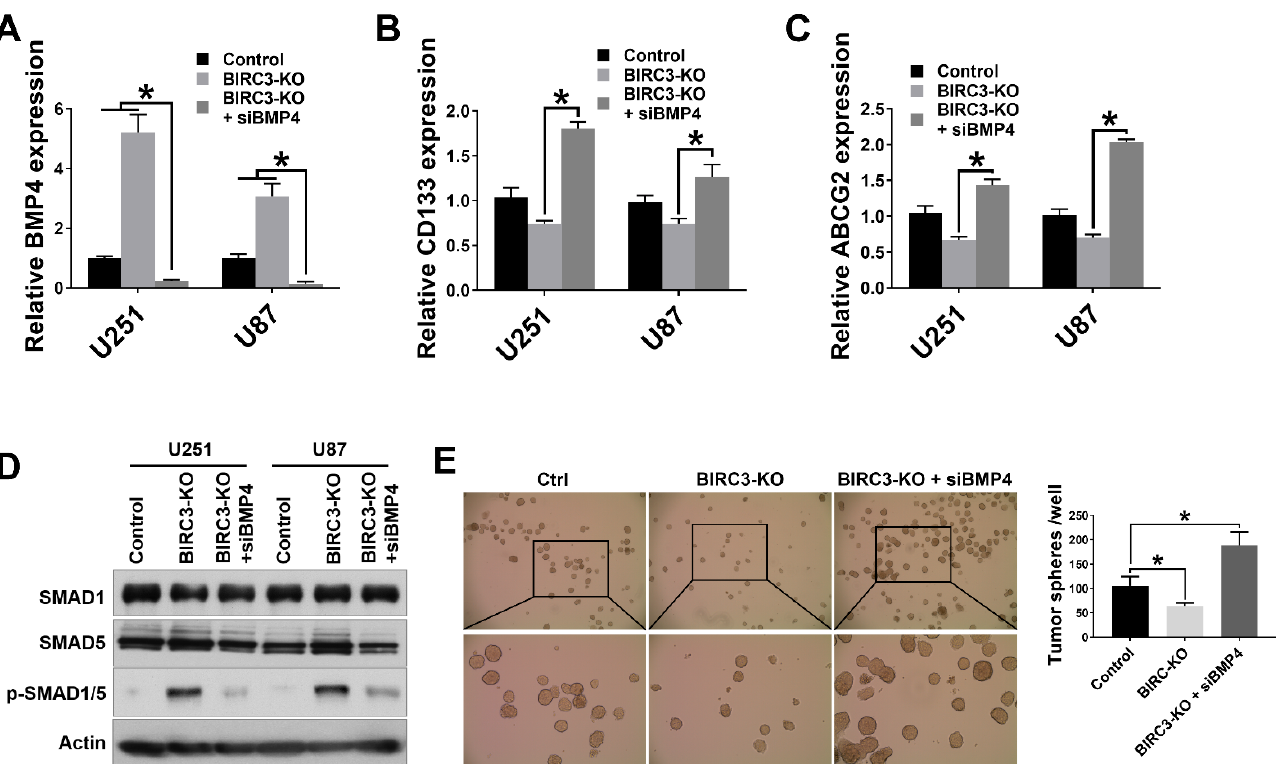
Figure 4. BIRC3 impacts GBM cell self-renewal and is dependent on BMP4 suppression. ( A ). Human BMP4 mRNA expression analyzed by real time PCR in control, BIRC3-KO, and BMP4-siRNA silenced BIRC3-KO U251/U87 GBM cell lines. n = 3, * p < 0.05. ( B ). Human CD133 mRNA expression analyzed by real time PCR in control, BIRC3-KO, and BMP4-siRNA silenced BIRC3-KO U251/U87 GBM cell lines. n = 3, * p < 0.05. ( C ). Human ABCG2 mRNA expression analyzed by real time PCR in control, BIRC3-KO, and BMP4-siRNA silenced BIRC3-KO U251/U87 GBM cell lines. n = 3, * p < 0.05. ( D ). Protein expression of SMAD1, SMAD5 and phosphorylated SMAD1/5 in control, BIRC3-KO, and BMP4-siRNA silenced BIRC3-KO U251/U87 GBM cell lines. Specific antibodies as indicated. β -actin acts as internal control. ( E ). Control or BIRC3-KO of U251 cells were seeded in 6 well plates and cultured in neurosphere formation medium. The BIRC3-KO cells had been treated with control siRNA and BMP4 siRNA separately 1 day before seeding. The number of neurospheres were observed and calculated by microscope. Representative images are under 4× magnification (top raw) and 10× magnification (bottom raw). n = 5, * p < 0.05.